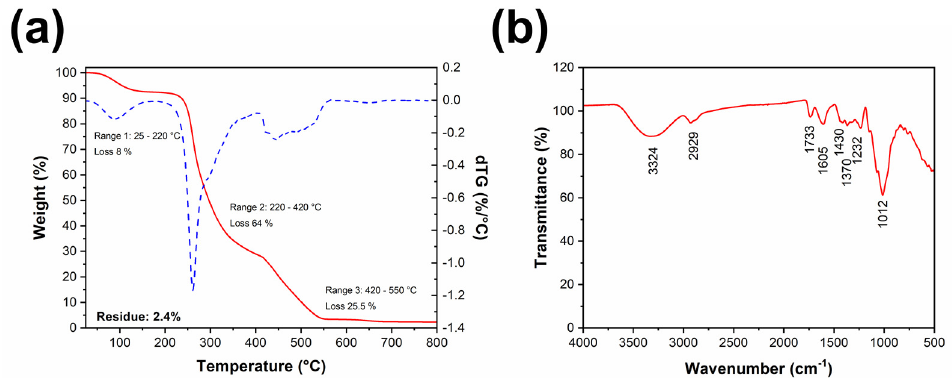
Figure 1. ( a ) Tragacanth gum TGA thermogram (red line) and its fi rst derivative (derivative ther- gravimetry (DTG), blue dotted line); ( b ) FTIR spectra of intact tragacanth gum mogravimetry (DTG), blue do tt ed line); ( b ) FTIR spectra of intact tragacanth gum (TG).